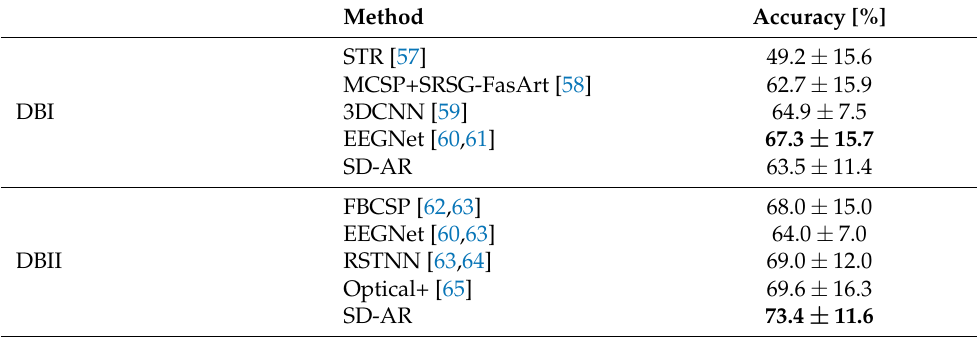
Table 4. Comparing the SD-AR classification accuracy of MI tasks with existing state-of-the-art methods reported for DBI (four classes) and DBII (bi-class). Bold stands for the best